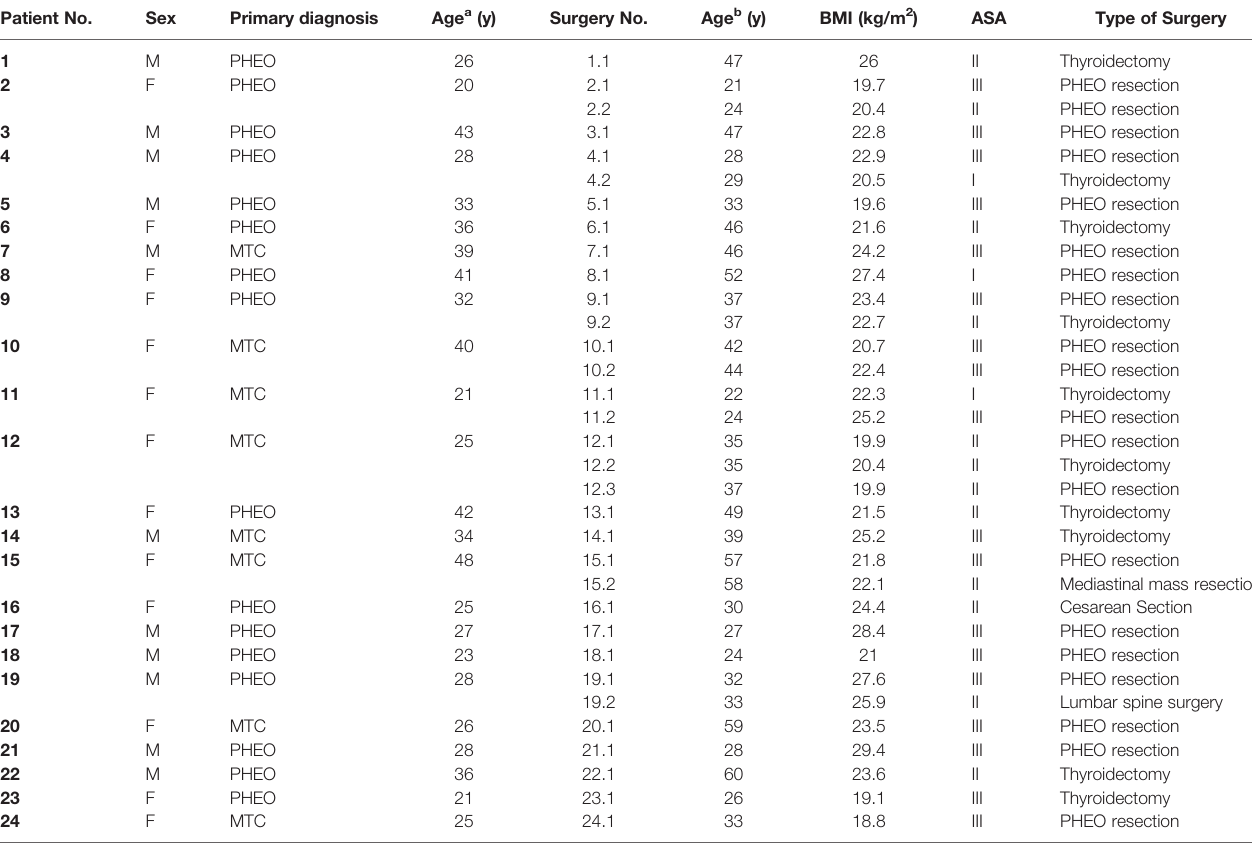
TABLE 1 | Primary diagnosis, demographics and surgeries of MEN2A patients. Patient No.